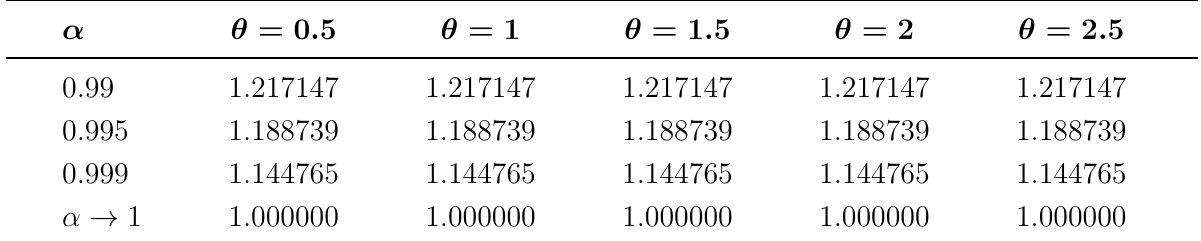
Table 3. Values for the ES/VaR ratio for Exponential ( θ ) distributions.